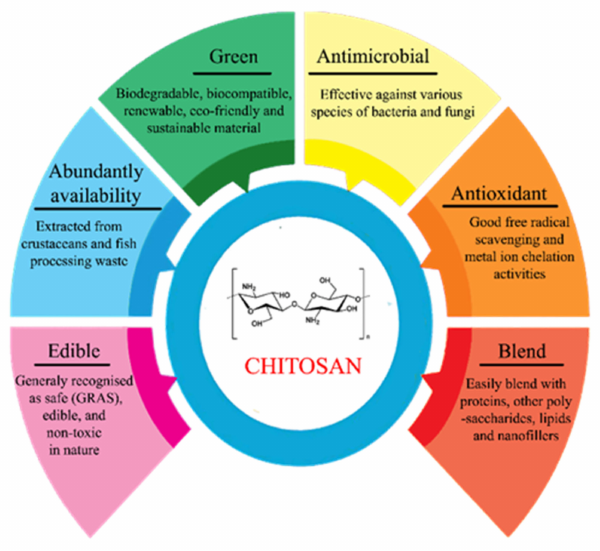
Figure 1. Chemical characteristics and functional properties of